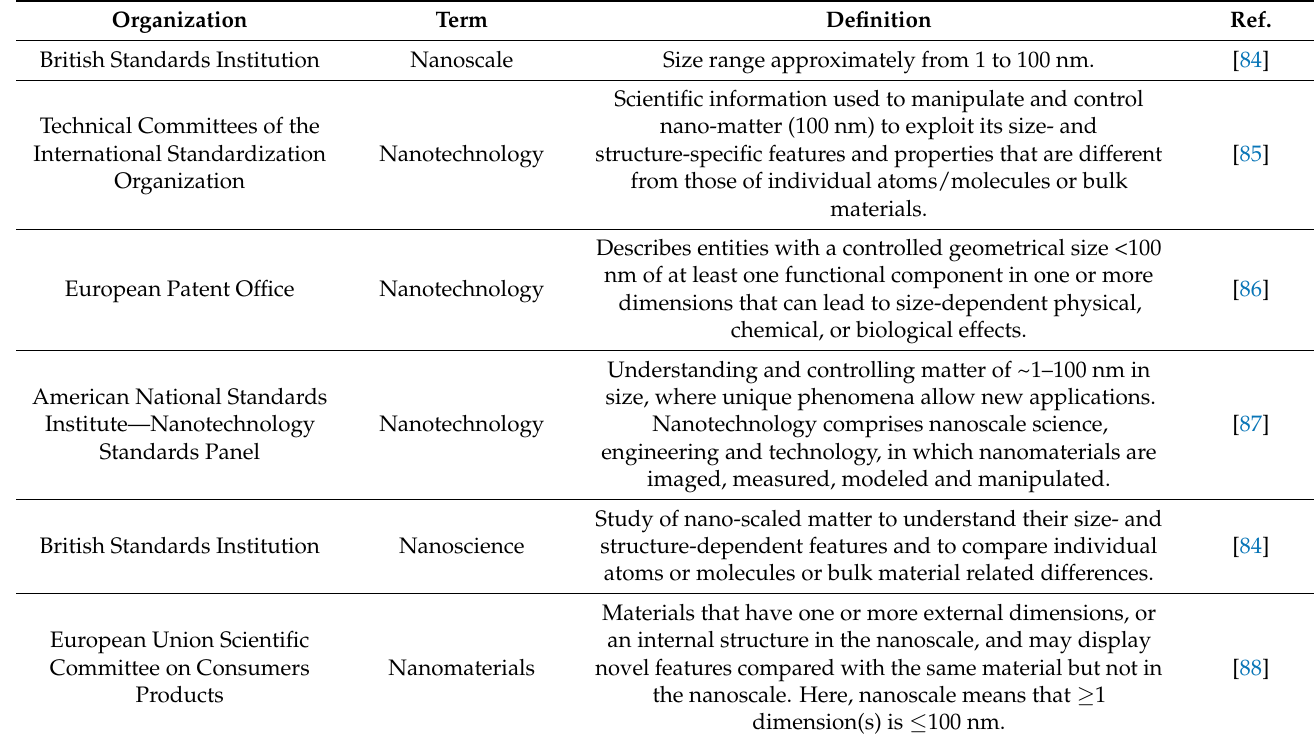
Table 1. Nanotechnology definition by international